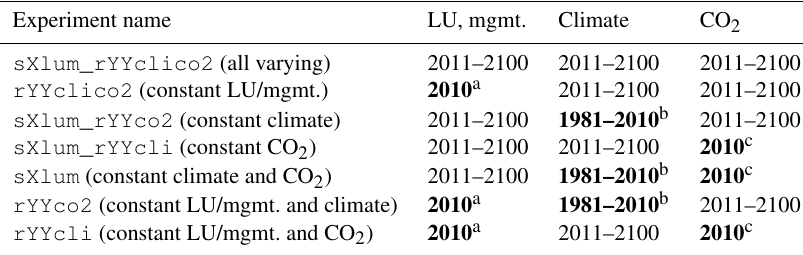
Table 1. Naming convention for LandSyMM runs analyzed in this work, based on land use and management (LU, mgmt.), climate, and CO 2 inputs. Bold indicates factors held constant in experimental runs. X refers to one of the SSPs (1, 3, 4, 5); YY refers to one of the RCPs (4.5, 6.0, 8.5). Unless otherwise specified, land use forcings are harmonized outputs from PLUM run fed with RCPY.Y-forced LPJ-GUESS potential yields and SSPX socioeconomic data and assumptions, and climate and CO 2 forcings are from RCPY.Y. Experiment name LU,